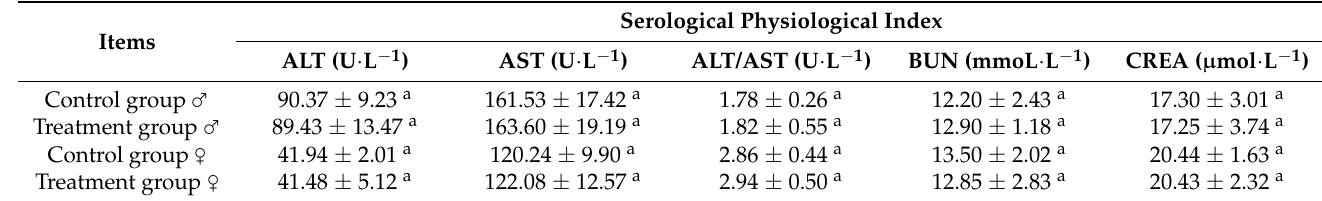
Table 11. The serological physiological indexes of mice in each